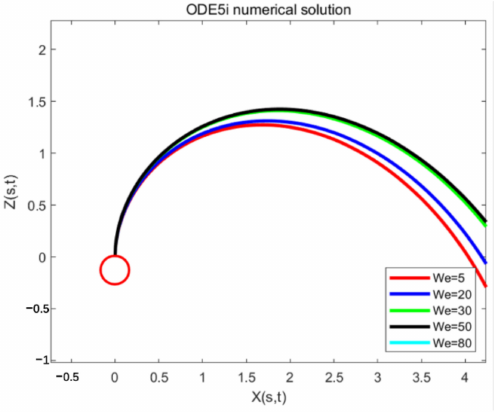
Figure 10. Jet trajectory diagram by using the implicit Runge-Kutta method ODE15i to solve the jet model, when the iteration interval is [0:300], the Rossby value Rb = 2, and different Weber numbers We = 5, 10, 20, 30, 50, 80.